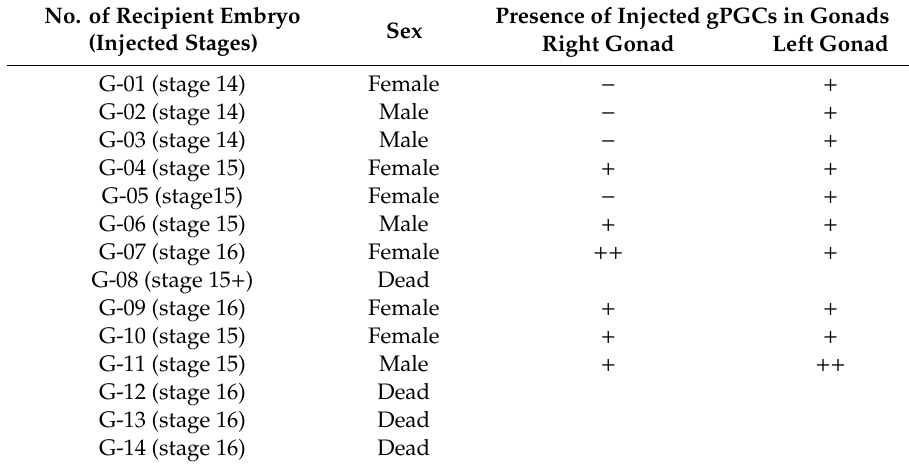
Table legend . G 01–14 = recipient embryos that received gPGCs; ‘ − ’ no colonization; ‘ + ’ gonad colonized at the moderate level; ‘ ++ ’ highly colonized